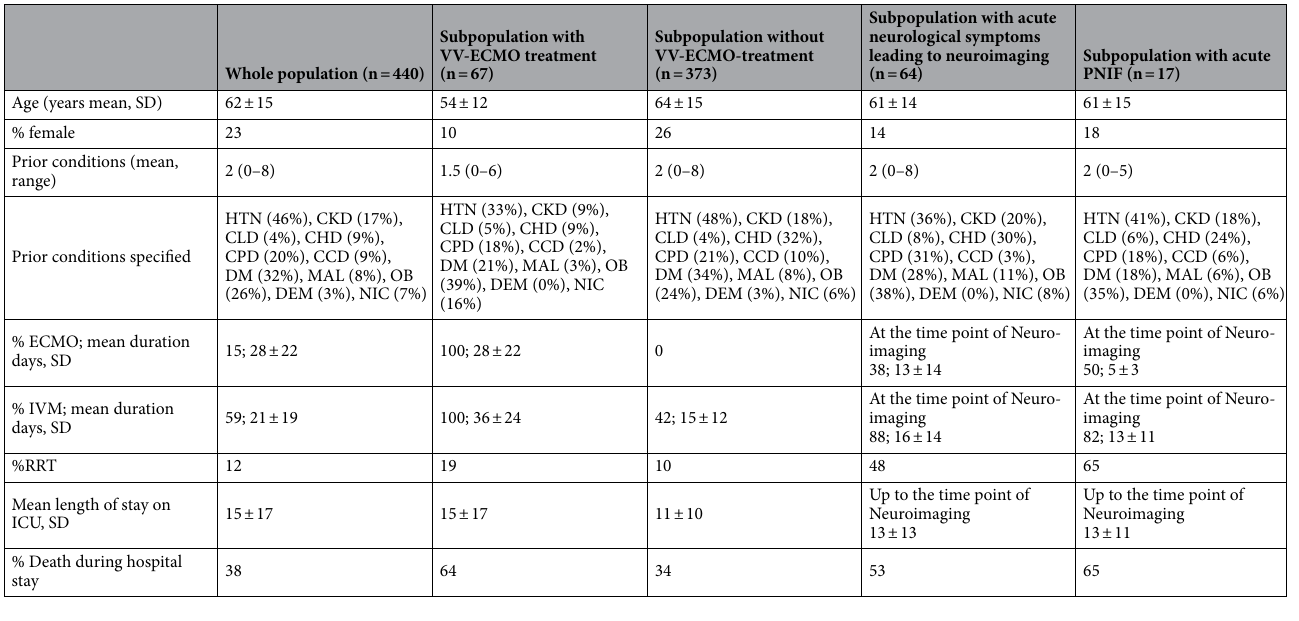
Table 2. Patient characteristics including subpopulations. HTN hypertension, CKD chronic kidney disease, CLD chronic liver disease, CHD chronic heart disease, CPD chronic pulmonary disease, CCD chronic cerebro- vascular disease, DM diabetes, MAL malignancy, OB obesity defined by body mass index (BMI; kg/m 2 ) ≥ 30, DEM clinically proven dementia, NIC smoking. Smoking is likely to be underreported.